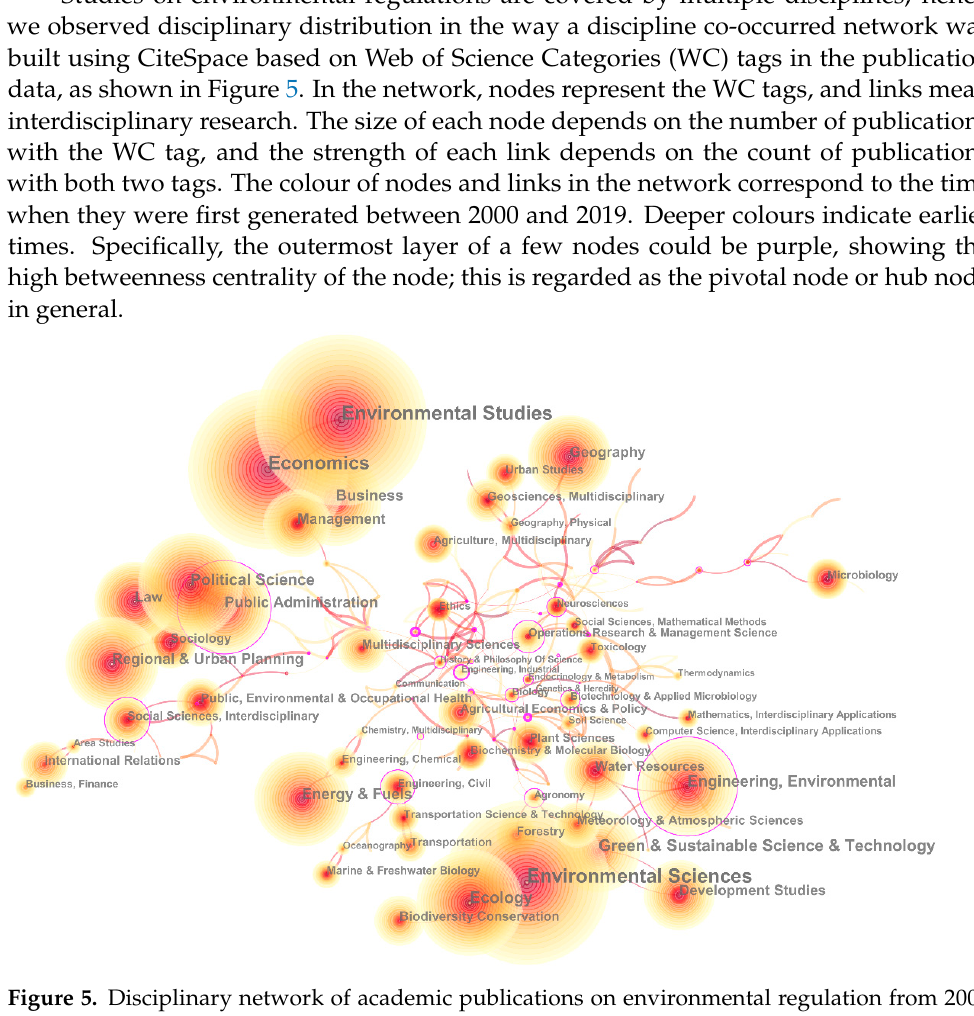
Figure 5. Disciplinary network of academic publications on environmental regulation from 2000 to 2019.